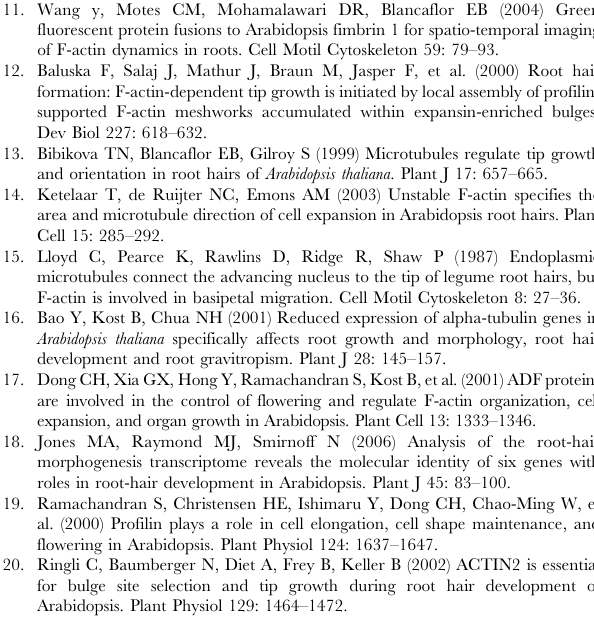
Table S1 Primers used in PCR reactions.